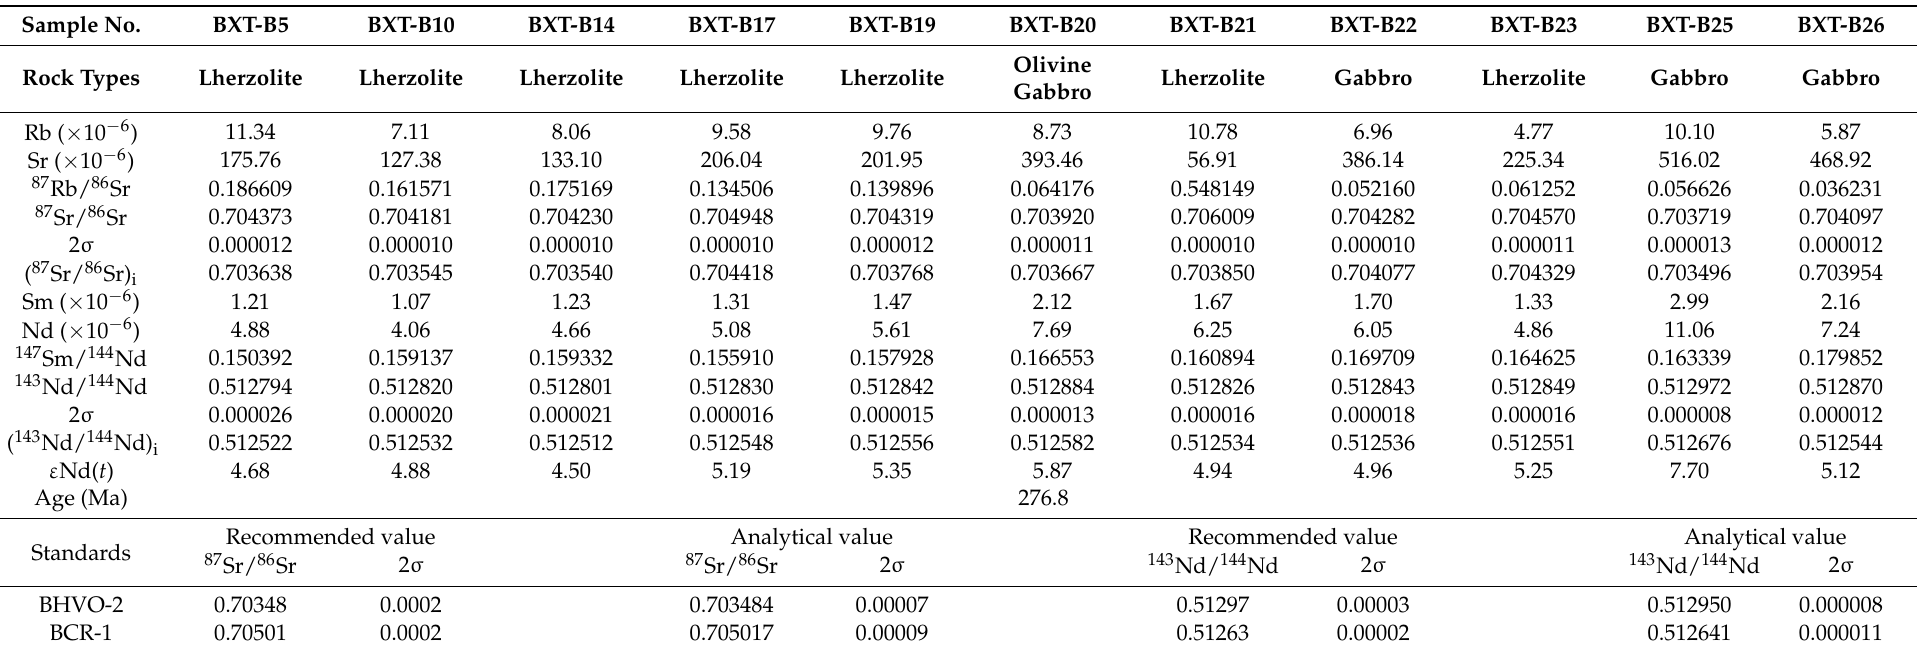
Table A4. Sr-Nd isotopic analytical results of samples from the Baixintan